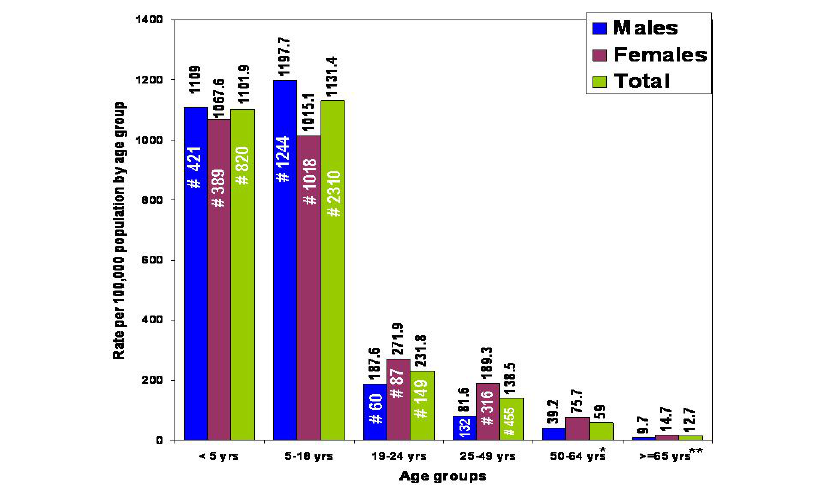
Figure 3. H1N1pdm Infection Rate per 100,000 Population, by age group in Milwaukee County, WI, from April 26, 2009 to July 25, 2009. Rate per 100,000 shown as numbers above bars; #, number of cases; * N (50–64 year age group) = 32, 67, 101 for Males, Females and Total (including gender not known). ** N for ≥ 65 years = 4, 10, 14 for Males, Females and Total (including gender not